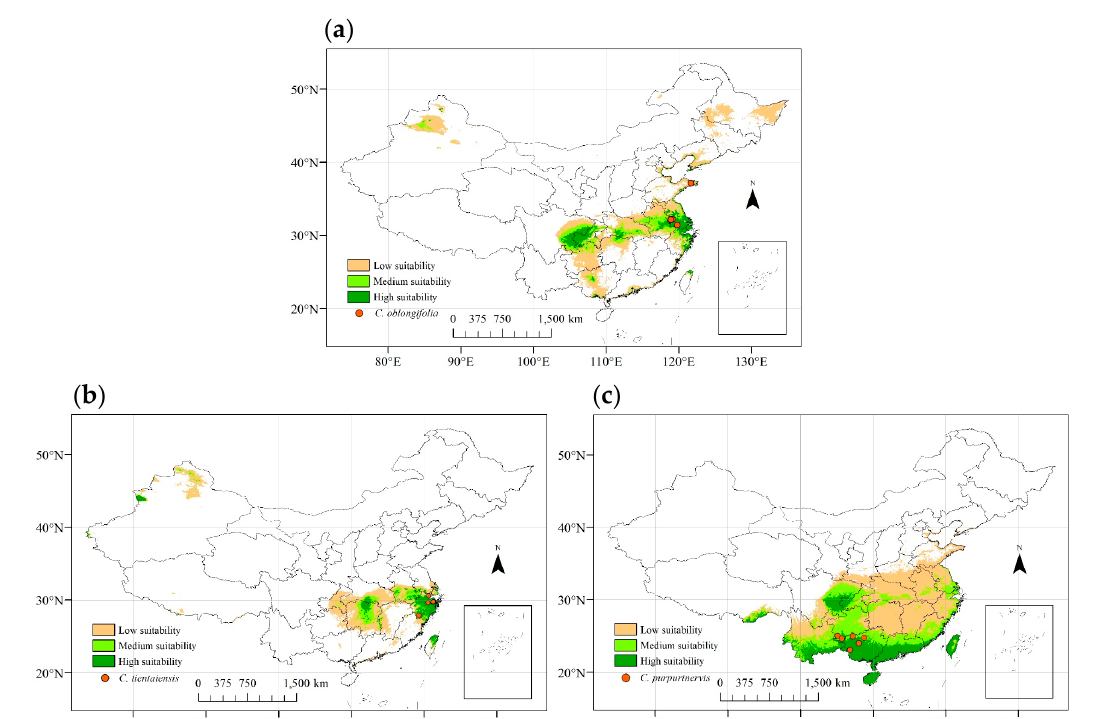
Figure 3. Potential distributions of the current (1970–2000) suitable habitats of three Carpinus species in China: ( a ) C. oblongifolia habitats; ( b ) C. tientaiensis habitats; ( c ) C. purpurinervis habitats.